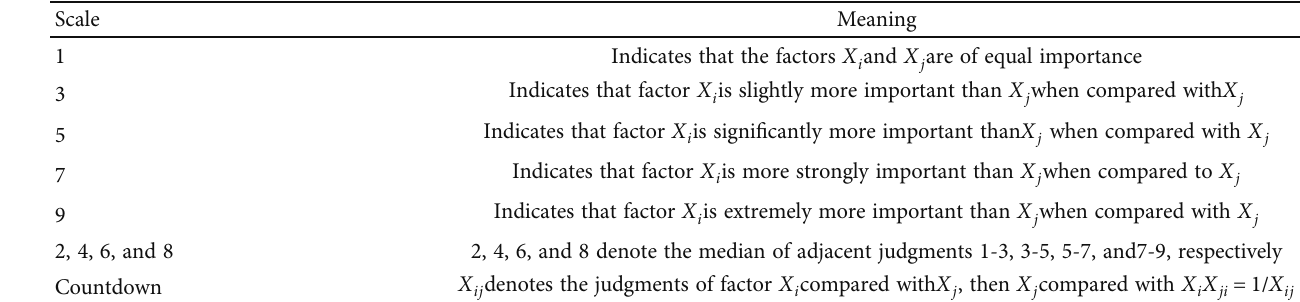
Table 2: Relative importance value table.